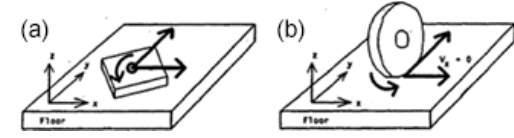
Figure 5. (a) Planar contact and (b) point